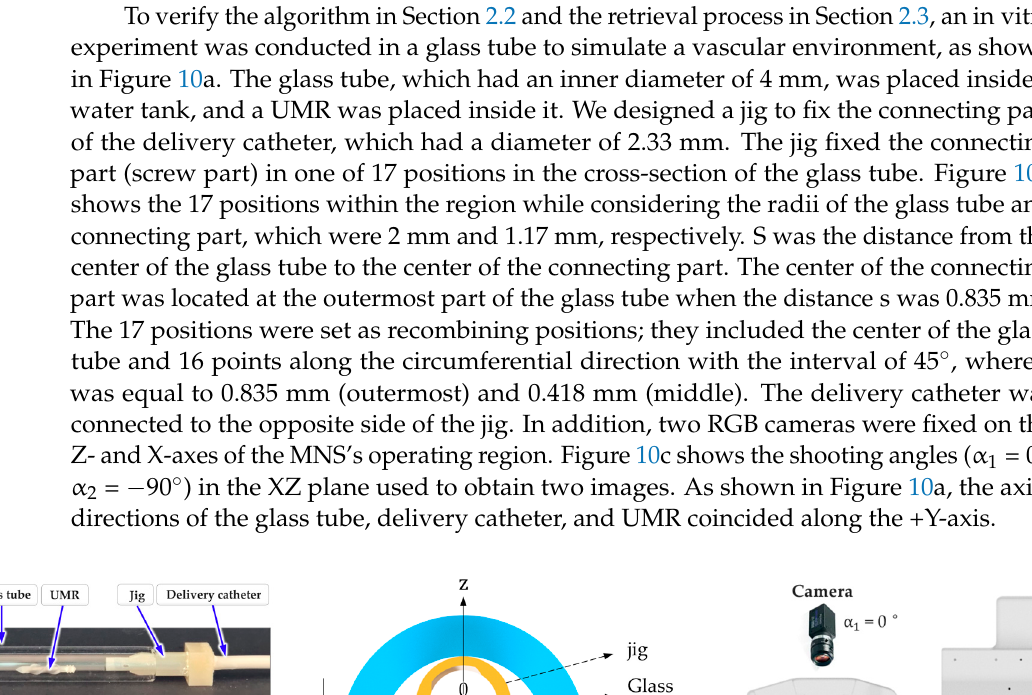
Figure 9. Procedure for recombining the UMR with the delivery catheter by applying magnetic force F m , a rotational magnetic field B rot , and suction force to the UMR.